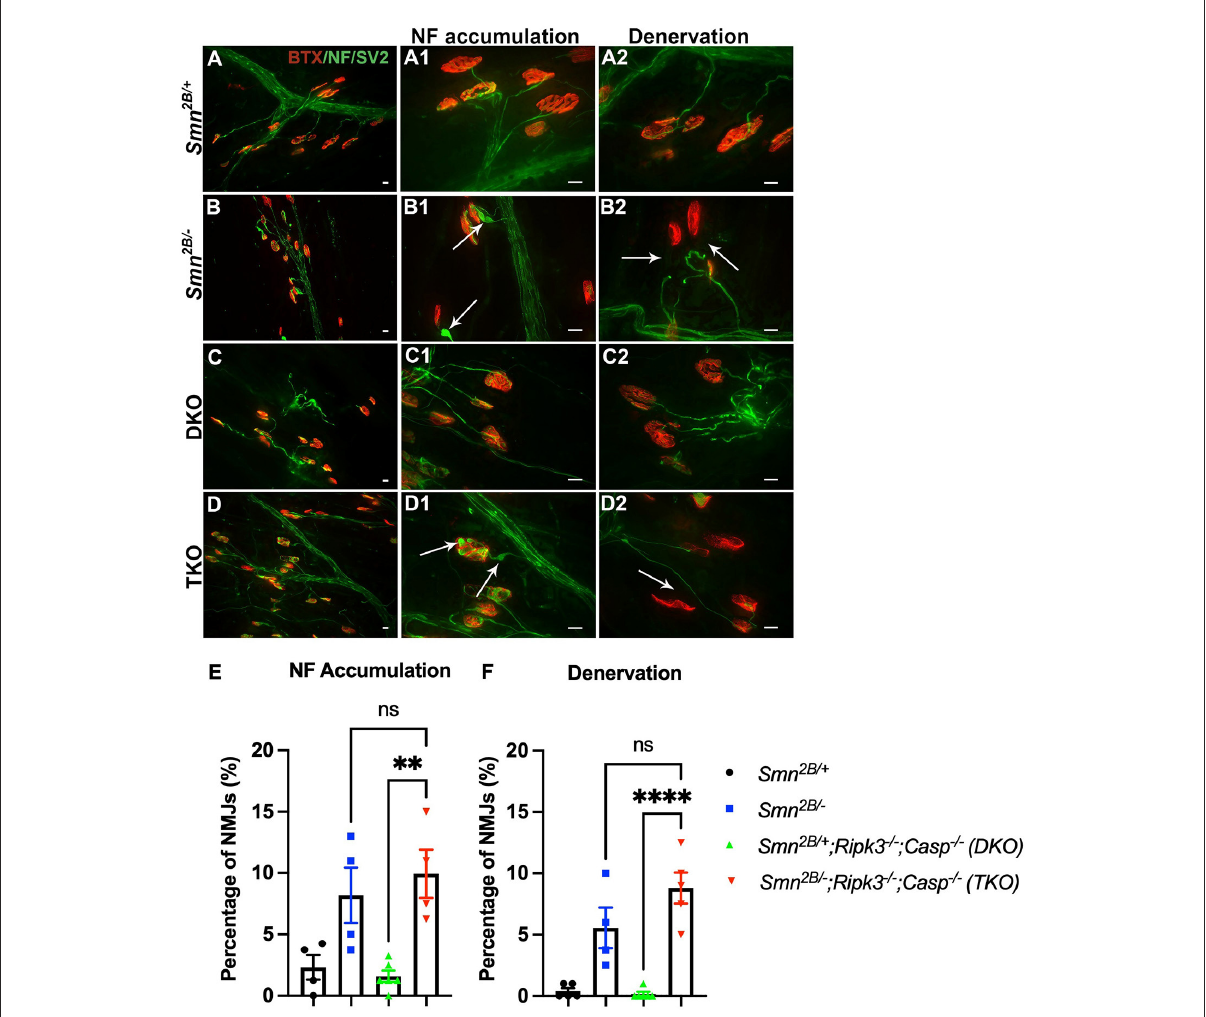
FIGURE5 Genetic ablation of necroptotic cell death pathways does not improve NMJ pathology in Smn 2 B / − mice. (A–D) Representative immunofluorescent images of the transversus abdominis (TVA) muscle stained with bungarotoxin (BTX; red) and for neurofilament (NF; green) and synaptic vesicle protein 2 (SV2; green). Quantification for NF accumulation (E) and denervation (F) in NMJs from P19 mice. White arrows show NF accumulation in (A1–D1) and end plate denervation in (A2–D2) . Scale bars = 20 µ m. η = 4 − 6 per genotype. Data represent mean ± SEM. An ordinary one-way ANOVA with Tukey post-hoc test for multiple comparison. ns, non-significant. P < 0.001 for ** , and P < 0.0001 for ****